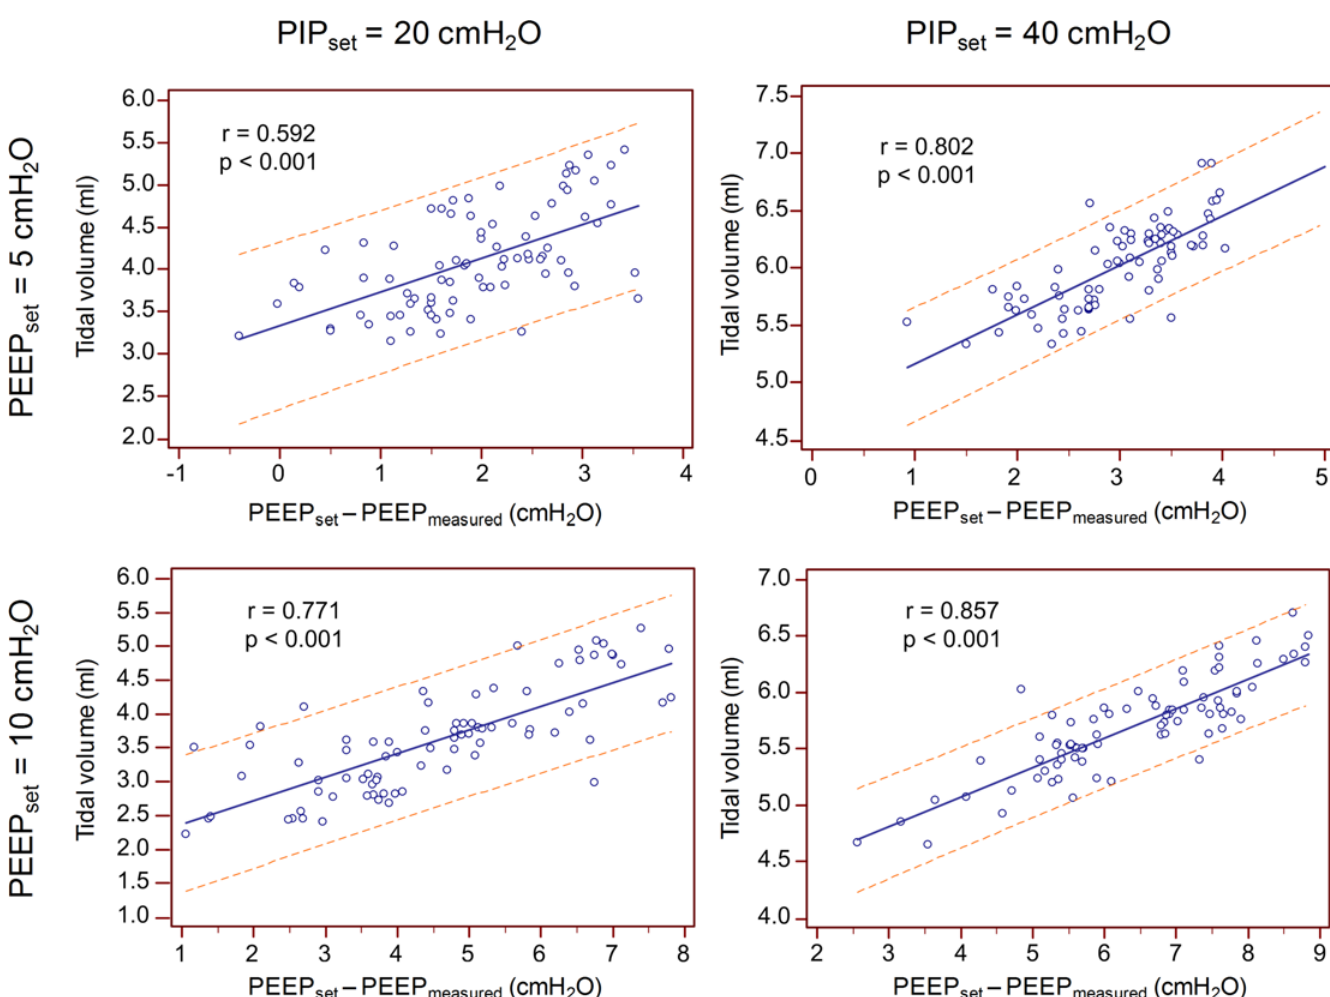
Fig 5. Effect of PEEP on tidal volume. Increase of the delivered tidal volume(V t ) with increasing difference between the set and delivered PEEP for a PEEP setting of 5 cmH 2 O (top) and 10 cmH 2 O (bottom) and PIP of 20 cmH 2 O (left) and 40 cmH 2 O (right). Presented is the regression line with 95% prediction